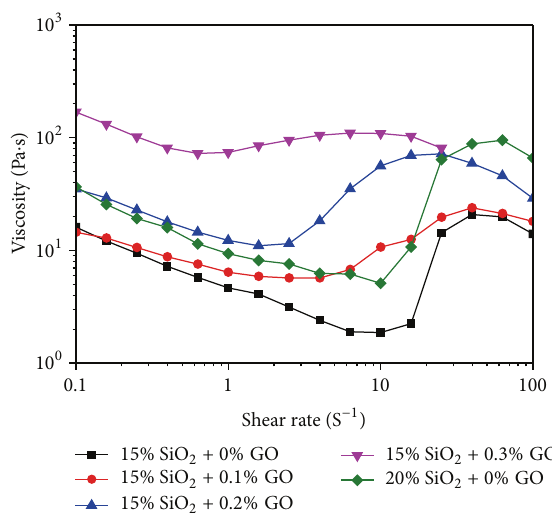
Figure 1: Steady shear sweep test of silica/PEG-based STF with various loading amounts of GO and silica (the numbers in the inset represent the concentration of each component in weight